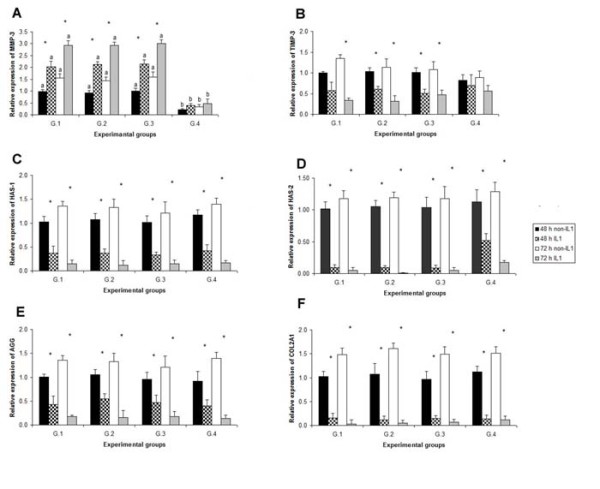
Relative expression of MMP-3 (A), TIMP-3 (B), HAS-1 (C), HAS-2 (D), AGG (E) and COL2A1 (F) in all experimental groups. Individual bars show the mean ± SD. A significant differences (p < 0.05) between the four groups at the same condition (48 h non-IL1, 48 h IL1, 72 h non-IL1 and 72 h IL1) is displayed with superscript (a, b) on the bars. A significant difference (p < 0.05) between treatment and non-treatment with IL-1β at the same period (48 or 72 h) is displayed with superscript (*) on the bars. G.1 = control group; G.2 = solution control; G.3 = non-silencing siRNA; and G.4 = MMP-3 siRNA.